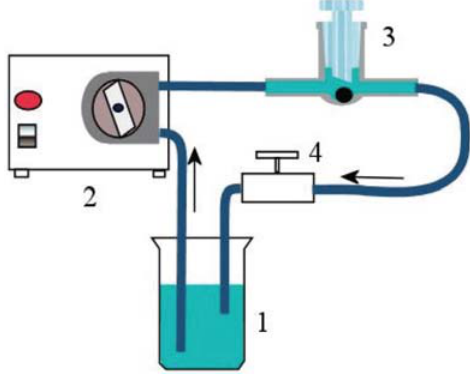
Figure 2 . Recirculating single drop micro extraction device with peristaltic pump: 1 sample reservoir, 2 peristaltic pump, 3 extrac- tion chamber, 4 Hoffmann clamp 5 Tygon